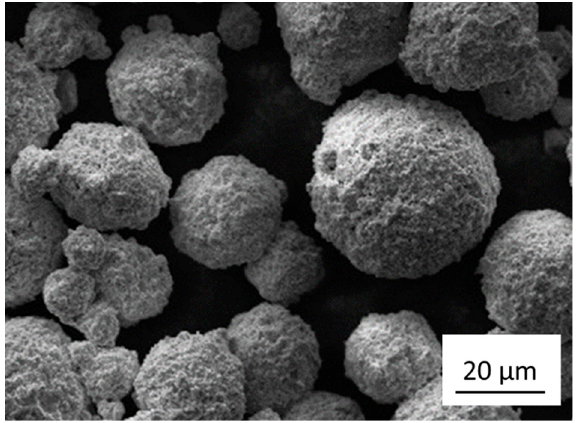
Figure 1. Scanning electron microscope (SEM) image of the powder. Table 1. Chemical composition (wt%) of the powder.